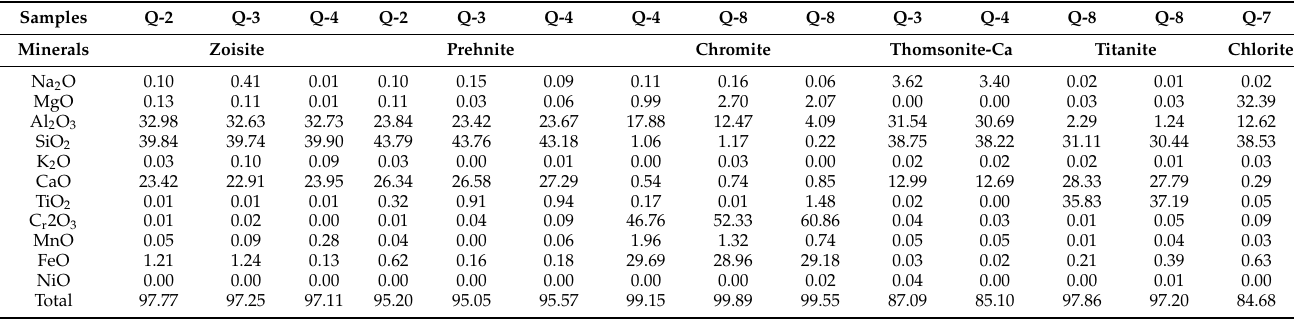
Table A1. Chemical compositions of zoisite, prehnite, chromite, thomsonite-Ca, titanite, and chlorite in the rock samples.